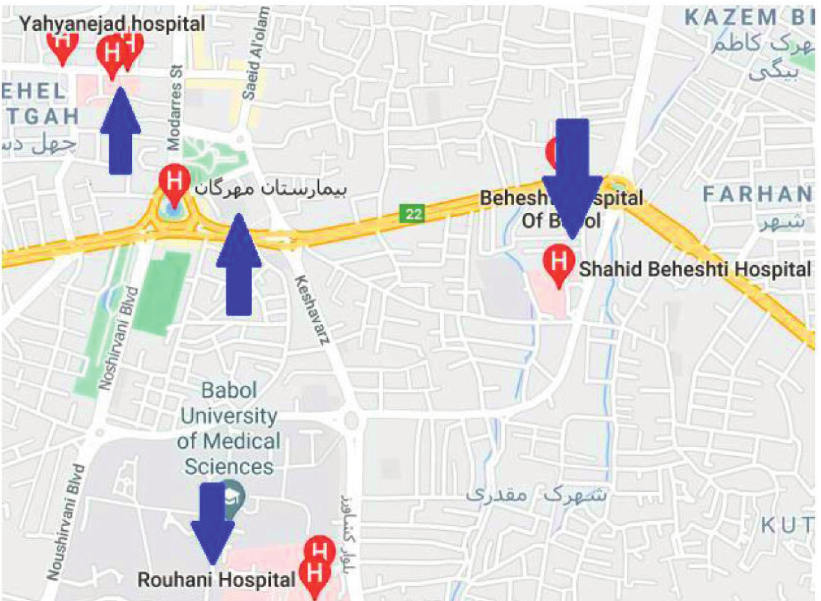
Figure 10: Location of hospitals in Babol City.